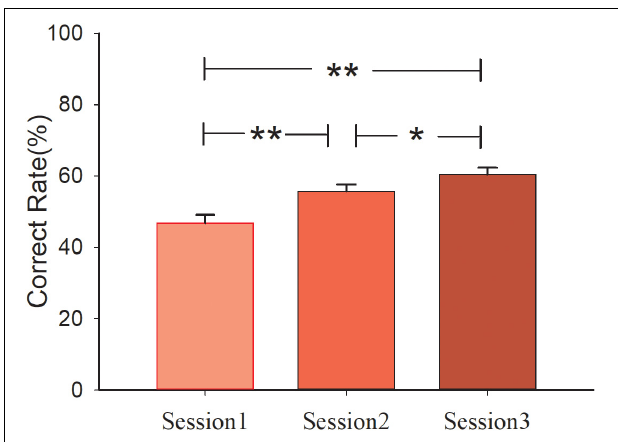
FIGURE 2 | Behavioral results for the three sessions. Participants’ correct rate in three sessions.